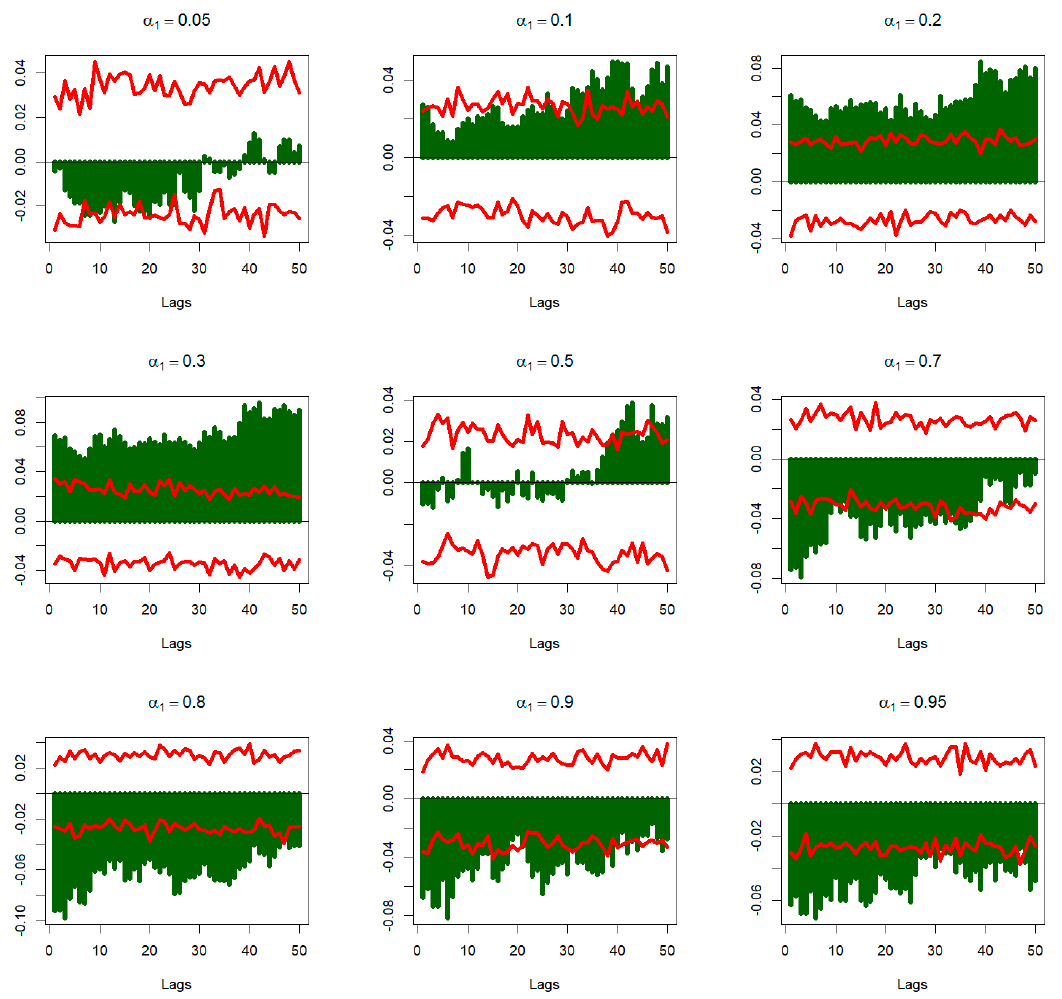
Figure 2. Sample cross-quantilograms for the median levels of TVRAs, i.e., for α 2 = 0.5. Note: This figure depicts the sample cross-quantilograms ( ˆ q a ( k )) to detect directional predictability from time-varying risk aversion measure (TVRA) to realized correlation jumps ( RCJ t ) , by estimating the lead-lag correlations contemporarily at di ff erent lags and quantiles. As for RCJ t , six quantiles are considered, in which α 1 ∈ { 0.05,0.10,0.20,0.30,0.40,0.5,0.60,0.70,0.80,0.9,0.95 } As for TVRA, three quantiles are considered, in which α 2 ∈ { 0.5 } corresponding to periods in which the TVRA is in its median levels. Bar graphs depict the ˆ q a ( k ) , while the red lines depict the 95% bootstrap confidence intervals for 1000 bootstrap iterations. For positive (negative) values of the ˆ q a ( k ) , a bar above (below) the red line leads to a rejection of the null hypothesis H 0 : ˆ q a ( k ) = 0 at a 5% significance level.